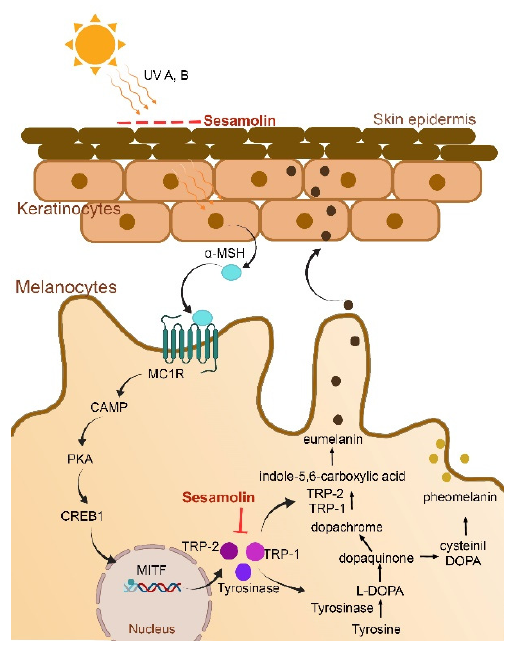
Figure 3. Sesamolin was able to inhibit melanin production via two mechanisms. (1) by blocking the UV radiation, which is the melanin inducer as sunscreen function (2) by downregulate the key mel- anogenic protein, tyrosinase, TRP-1 and TRP-2. The figure was created using Adobe Photoshop ver- sion 22.3.0. version